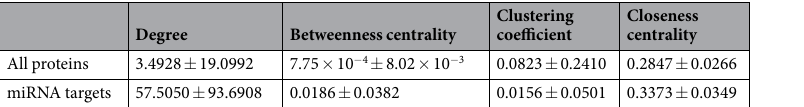
Degree Betweenness centrality